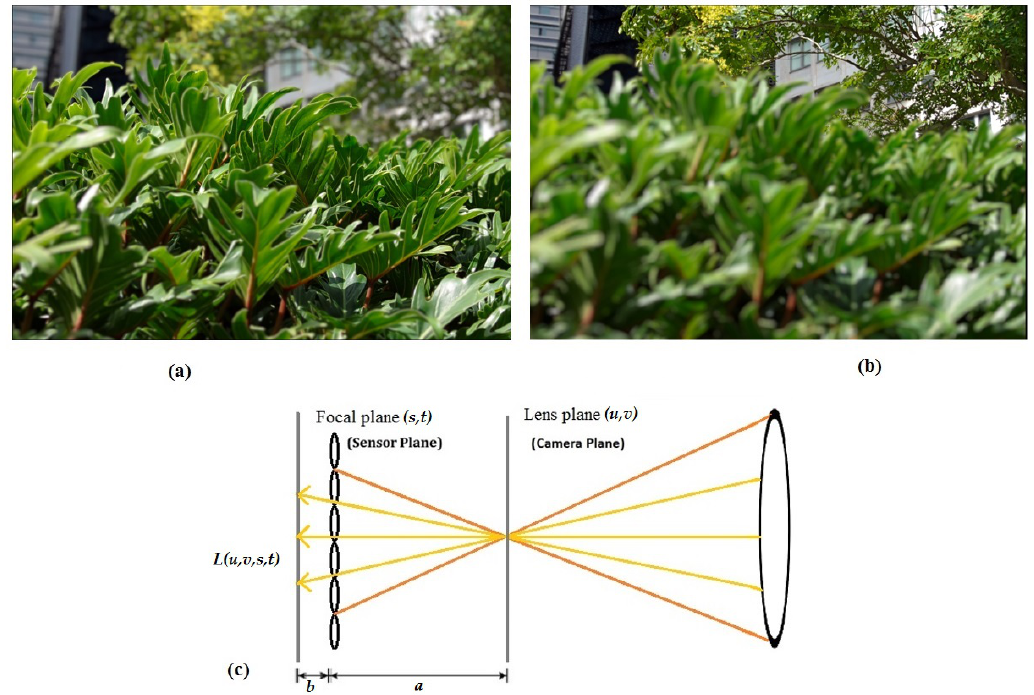
Figure 3. An illustration of the light field function and post-capture re-focusing. ( a ) Focus in the foreground. ( b ) Focus in the background. ( c ) A diagram of a light field camera setup where a is the distance from the camera plane to the sensor plane and b is the distance between the sensor and the micro-lens array.